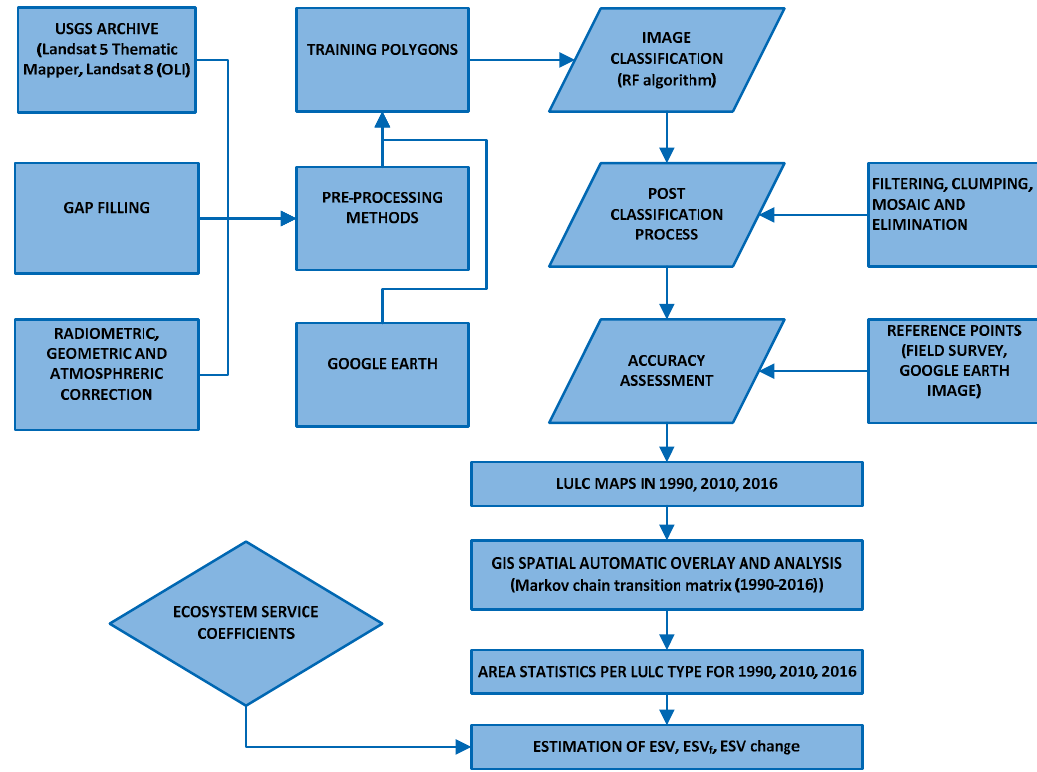
Figure 2. Flowchart of the methodological approach for this study (United States Geological Survey (USGS)); random forest (RF) alogarithm; land use and land cover (LULC); ecosystem service value (ESV); ecosystem service value of function (ESV f )). (Modified after Msofe et al., 2019).